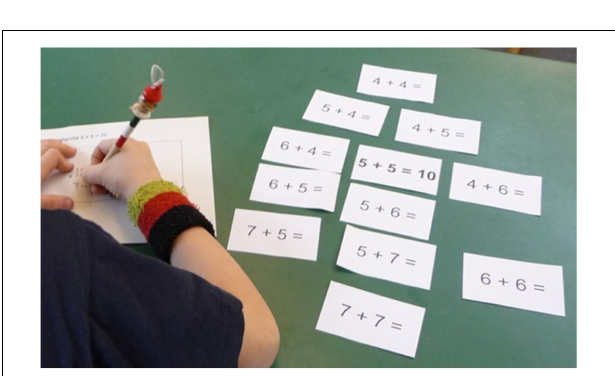
FIGURE 5 | Arranging a “Problem-Family” by placing terms together depending on their